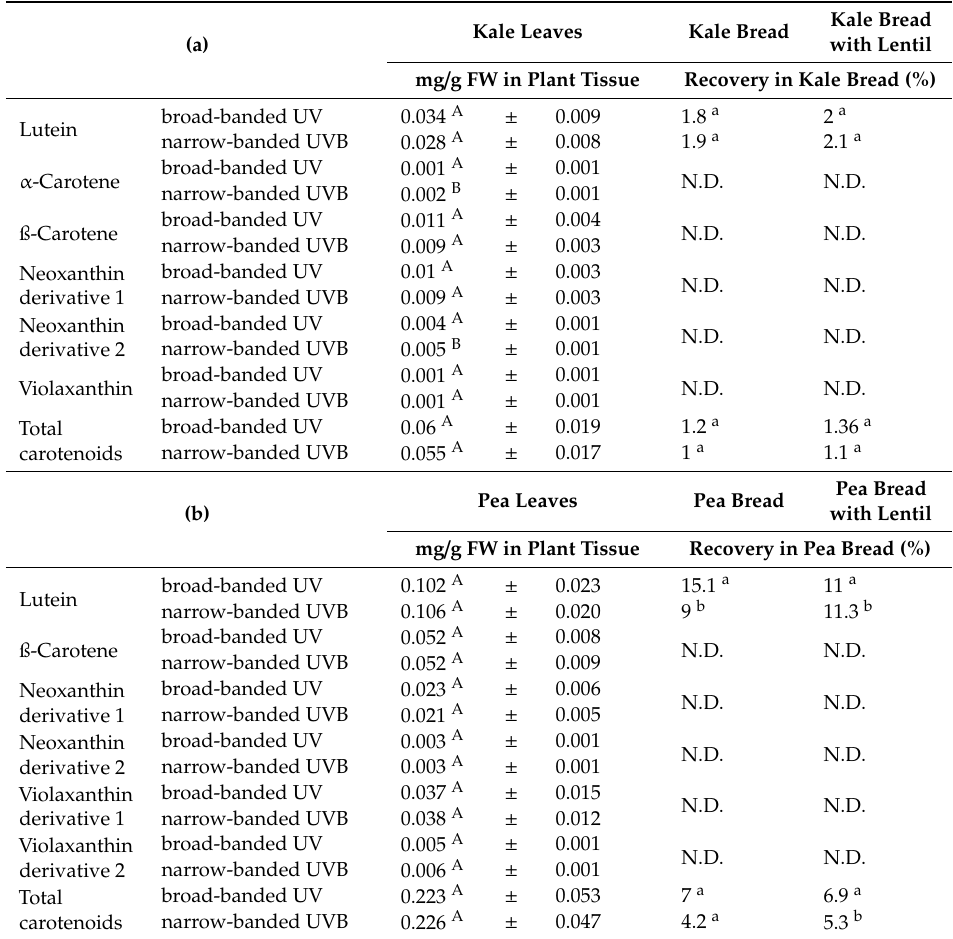
Table 1. Influence of narrow-banded UVB (ultraviolet B) and breadmaking on carotenoids in ( a ) kale and ( b ) pea